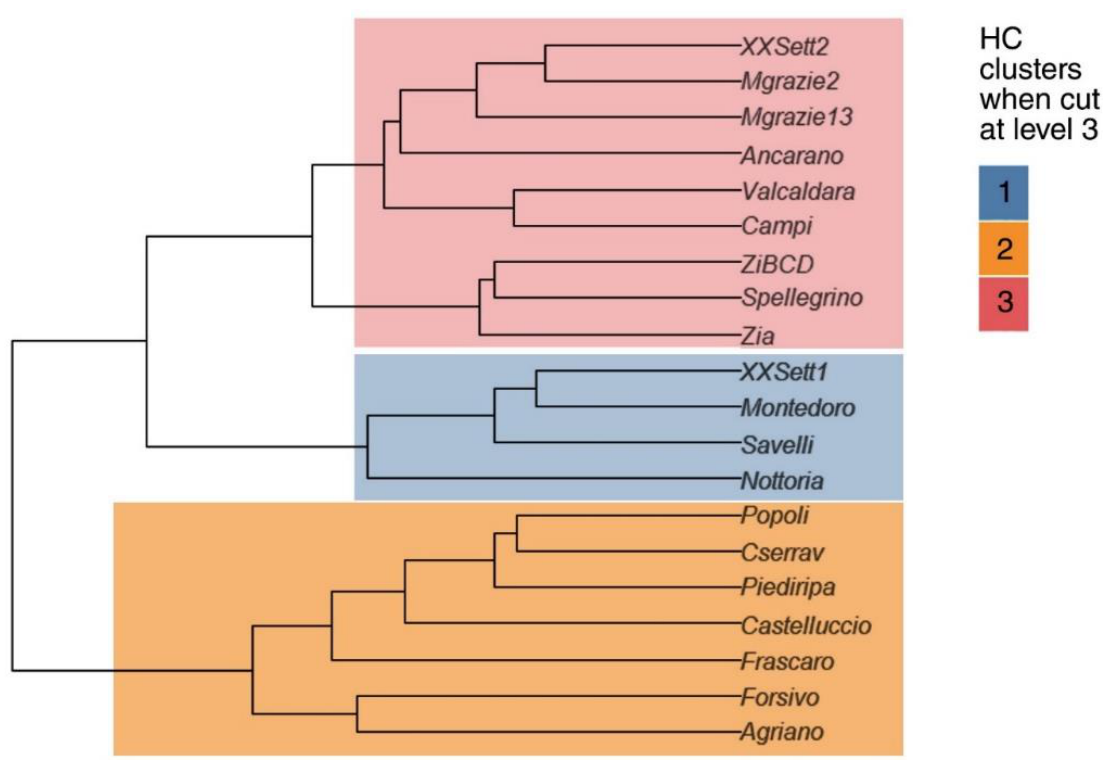
Figure 7 HC-derived dendrogram. The colours show the result when the tree is cut at